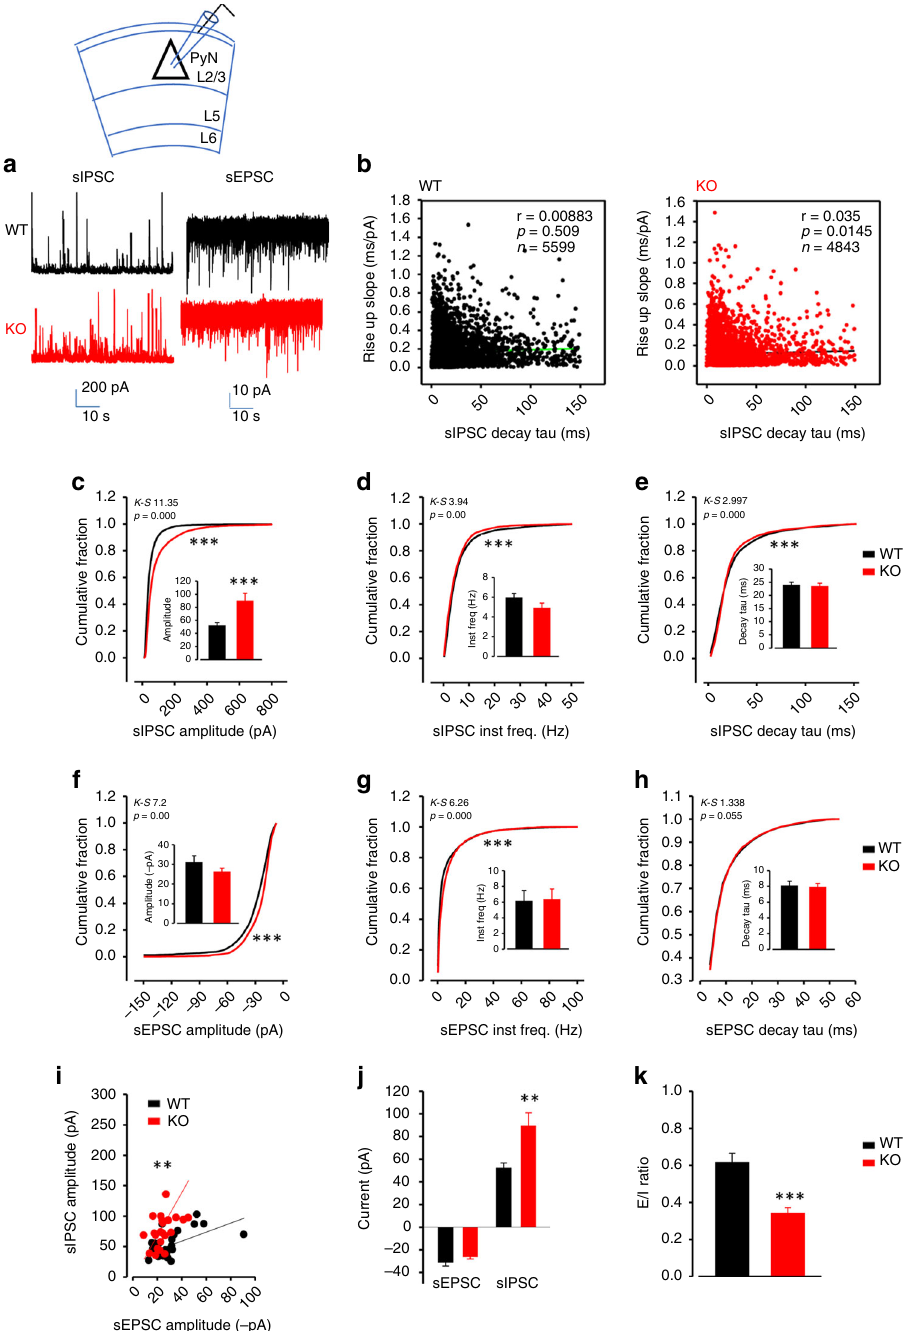
Fig. 3 Increased spontaneous inhibitory inputs (mostly from PV interneurons) to the somata of the dACC layer 2/3 pyramidal neurons in PV- Lmo4 KO mice. a Sample traces of sIPSC and sEPSC of WT (black) and KO (red). b Lack of correlation between sIPSC decay time and rise slope indicates these sIPSCs occur at the soma of L2/3 pyramidal neurons, where PV interneurons synapse (compare to Supplementary Fig. 4d). sIPSC ( c – e ) and sEPSC ( f – h ) properties are shown. i E-I relationship fi tted with linear regression from paired sIPSC and sEPSC amplitudes from each individual cell reveals a divisive change in KO. Increased sIPSC amplitudes in KO without altered sEPSC amplitudes ( j ) resulted in reduced E/I ratio ( k ). n = 26 cells/8 WT, 24 cells/8 KO mice. ** p < 0.01. *** p <